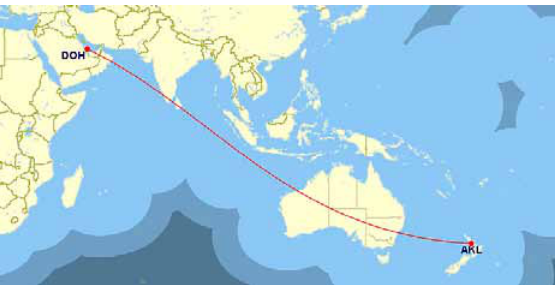
Fig. 4. The proposed Qatar Airways non-stop route from Doha to Auckland. Distance: 7,850 nm (14,540 km). Legend: AKL = Auckland; DOH = Doha. (Scalloped regions with light shading represent the extent of Boeing 777–200LR 120 minutes ETOPS; scalloped regions with dark shading represent the extent of Boeing 777–200LR 180 minutes